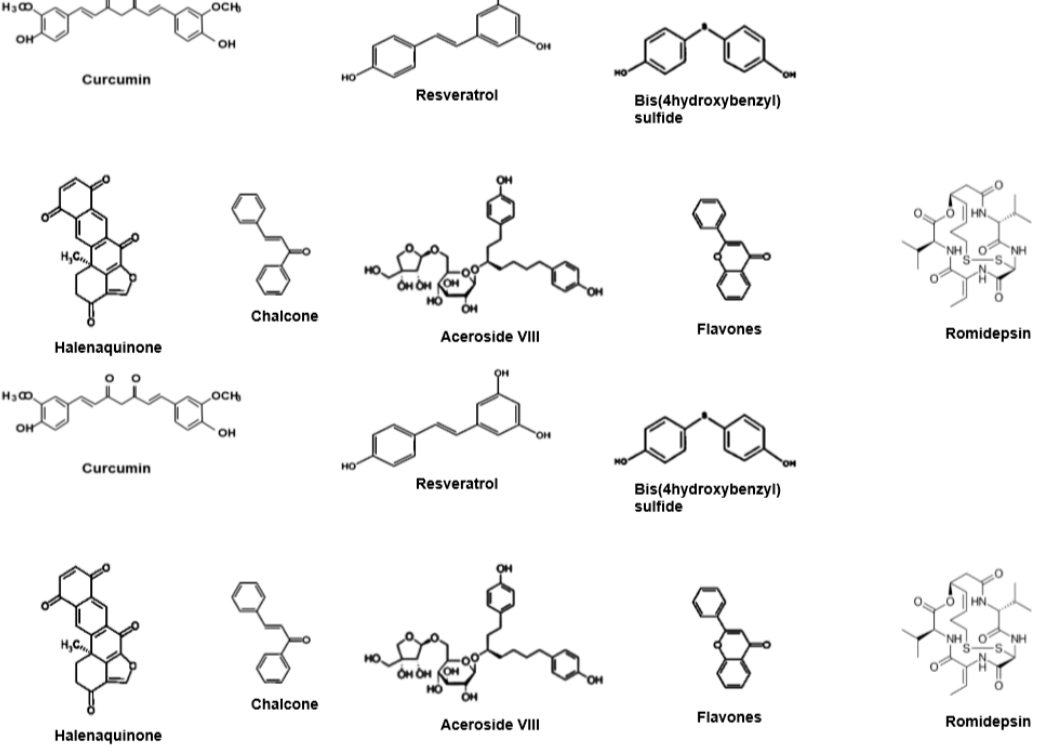
Figure 1. Structures of selected HDACi inhibitors from natural products.